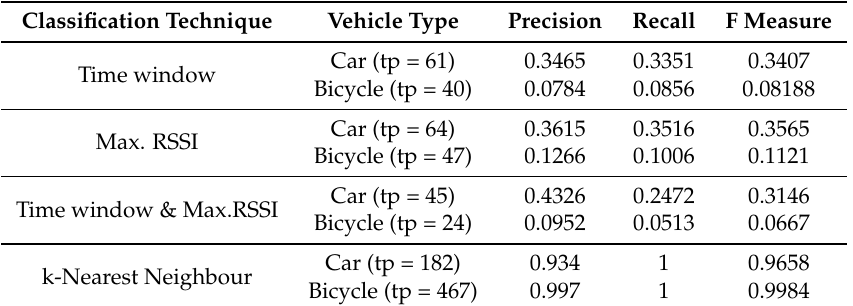
Table 6. Precision, Recall and F Measure using Heisenbergstrasse data (tp indicates the number of true positives).